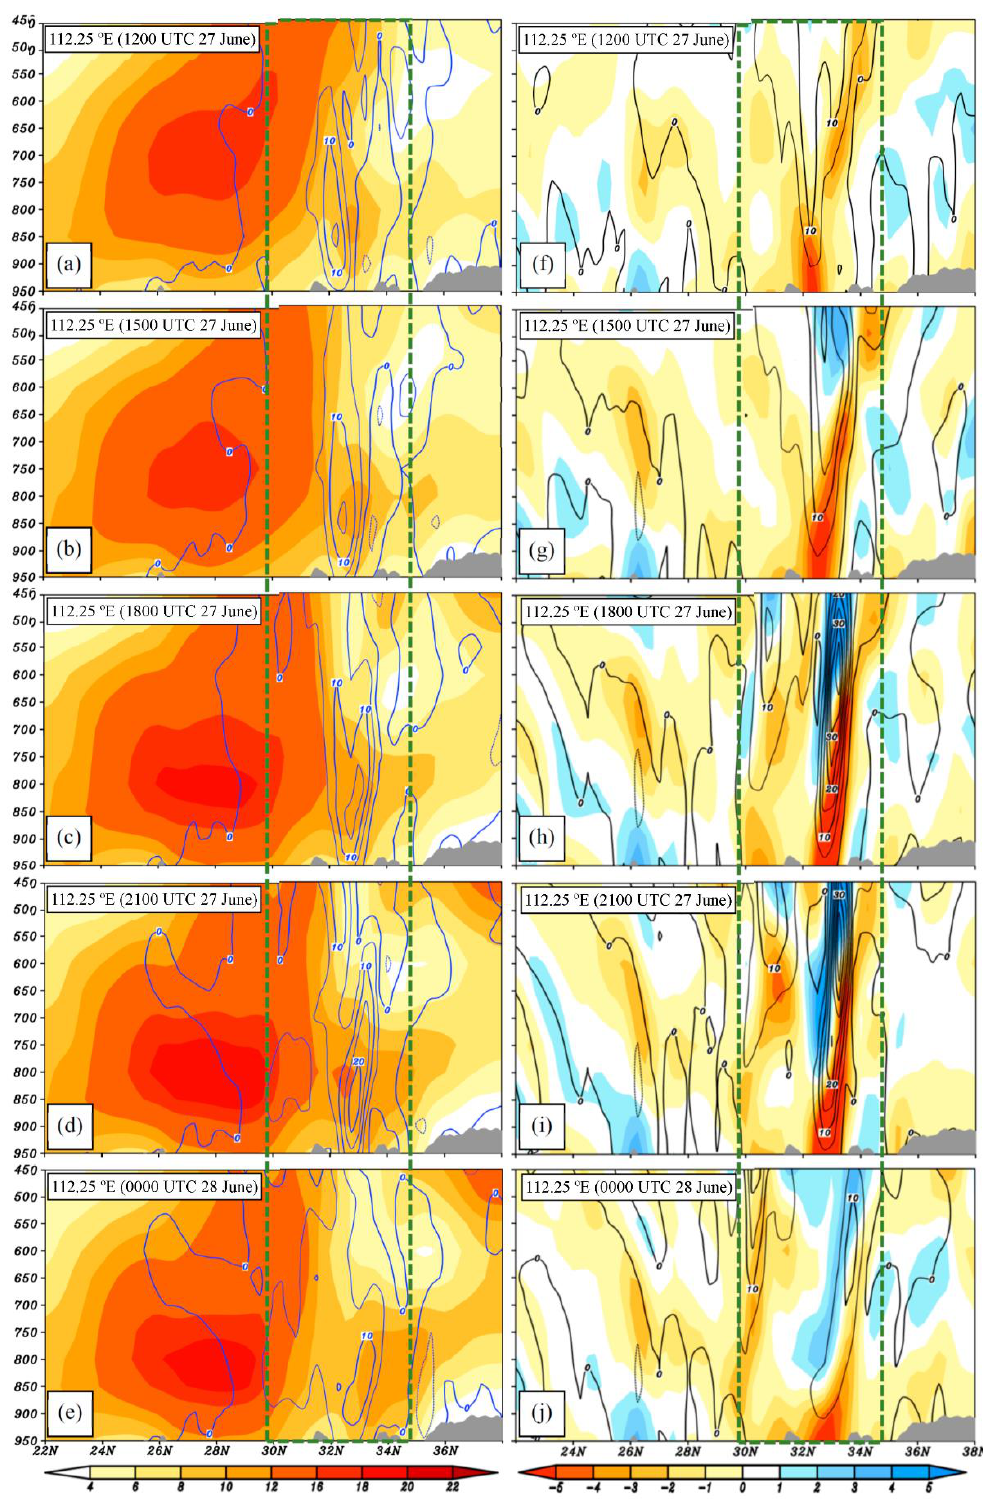
Figure 4. Panels ( a – e ) show the zonally (from 109.25 ◦ E to 115.25 ◦ E) averaged wind speed (shading, units: m s − 1 ), and vorticity (blue lines, units: 10 − 5 s − 1 ). Panels ( f – j ) illustrate the zonally (from 109.25 ◦ E to 115.25 ◦ E) averaged divergence (shading, units: 10 − 5 s − 1 ) and vertical velocity (black lines, units: cm s − 1 ). Grey shading shows the terrain, and the green dashed lines mark the central location of the mesoscale vortex. Y labels in all figures are pressure (units: hPa).